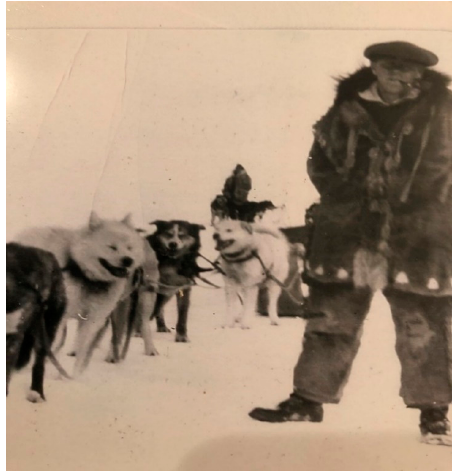
Figure 3. Ture Ek with his dog team in Canada’s north.